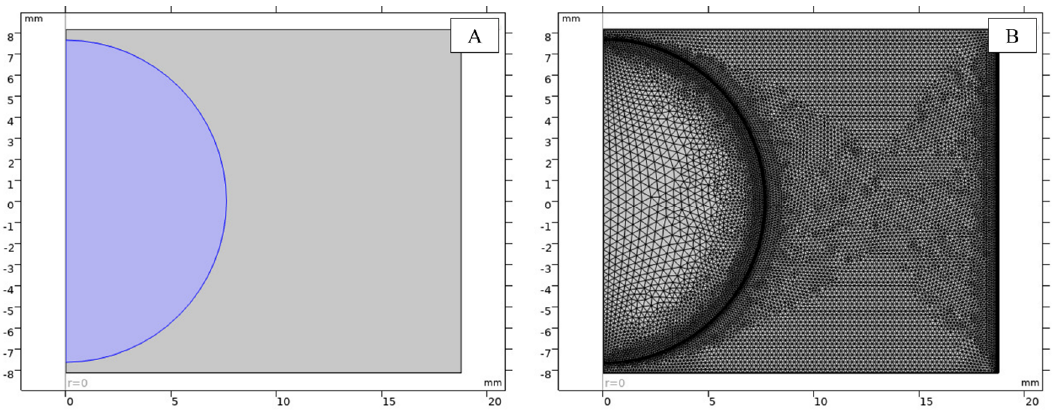
Figure 11. ( A ) Geometry of the 2D-axisymmetric model & ( B ) Physics controlled mesh.